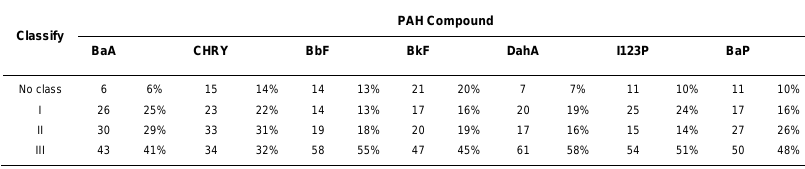
Summary of the Correlation Analysis Made using Individual PAH Data Measured from Seven Cities and Eight Provinces in Korea A. Results of the correlation analysis between cities/provinces for each PAH compound